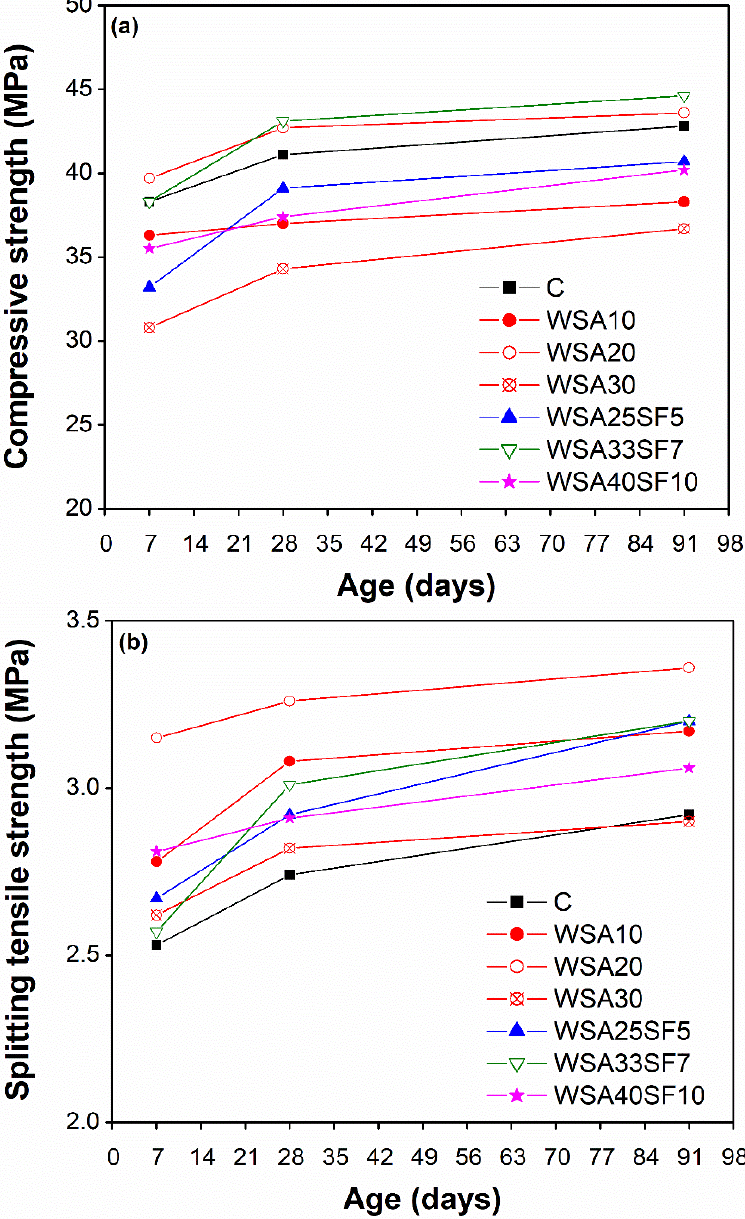
Figure 2. Comparison of strengths of control concrete and concrete having different percentages of WSA alone and blends of WSA with SF: ( a ) compressive strength and ( b ) splitting tensile strength. To summarize, the current findings demonstrated a decrease in compressive strength owing to a low (WSA10) or high (WSA30) cement replacement with WSA. Contrarily, a significant increase in both compressive and splitting tensile strength was obtained for 20% cement replacement with WSA (WSA20). Similar to binary concretes, the compres- sive strength of ternary concrete mixes decreased owing to a low (WSA25SF5) or high (WSA40SF10) cement replacements. However, a significant increase in both compressive and splitting strengths was observed for ternary concrete blend having 33% WSA jointly with 7% SF